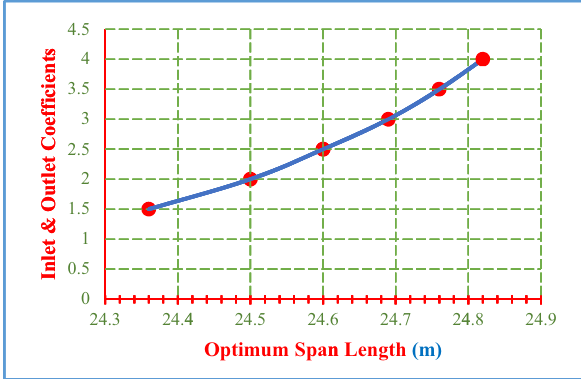
Figure 8: Optimum span length vs inlet and outlet coe ffi cients.